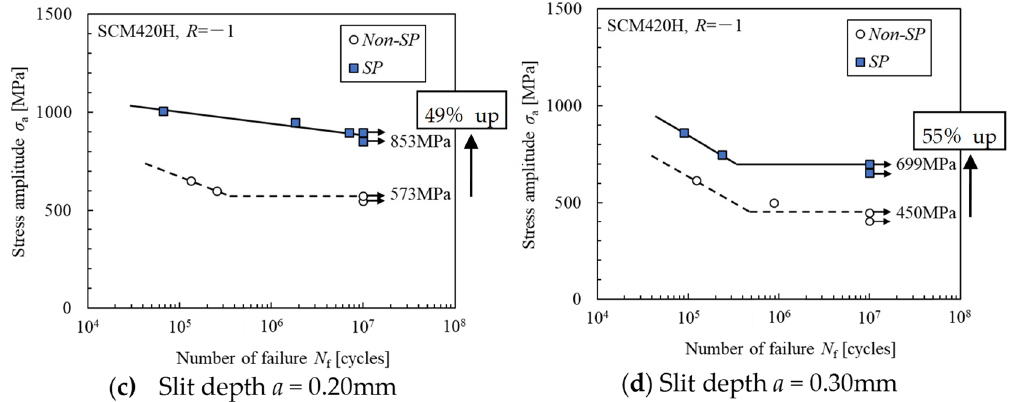
Figure 7. Fatigue test results. ( a ) Smooth, ( b ) Slit depth a = 0.15 mm, ( c ) Slit depth a = 0.20 mm, ( d ) Slit depth a = 0.30 mm.